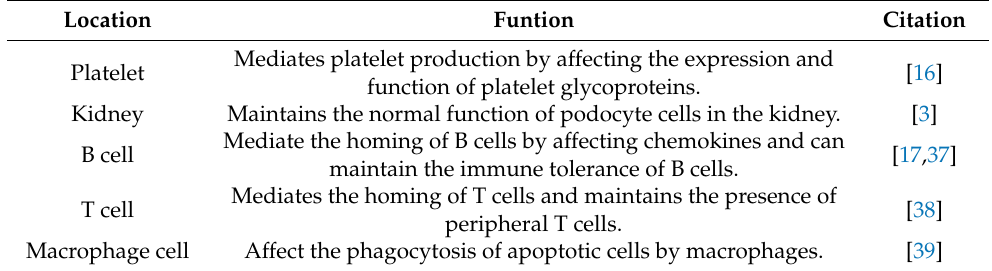
Table 1. Roles of Cosmc in normal